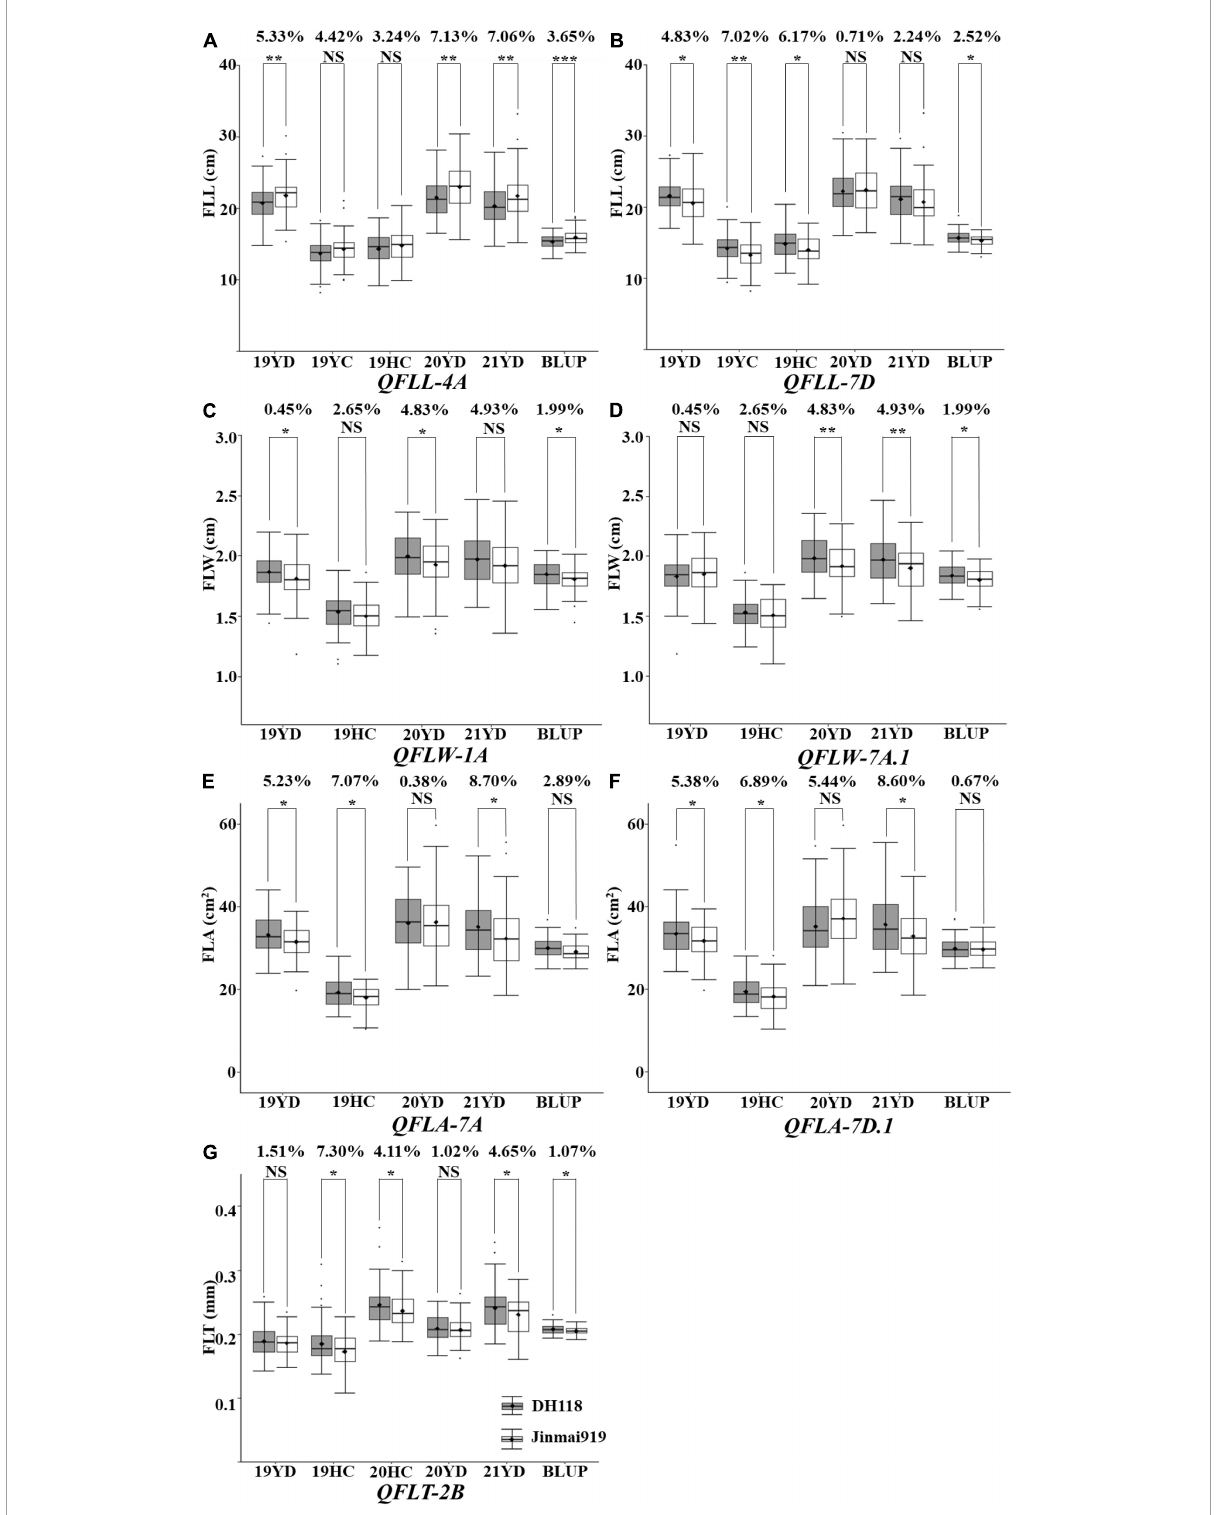
FIGURE6 Validation of 11 stable quantitative trait loci (QTL) in the DH118 × Jinmai 919 population. Effects of QFLL-4A (A) , QFLL-7D (B) on flag leaf length and effects of QFLW-1A (C) , QFLW-7A (D) on flag leaf width and effects of QFLT-2B (E) on flag leaf thickness and effects of QFLA-7A (F) and QFLA-7D (G) on flag leaf area. Designations *, **, *** and NS represent P < 0.05, P < 0.01, P < 0.001 and no significant difference,